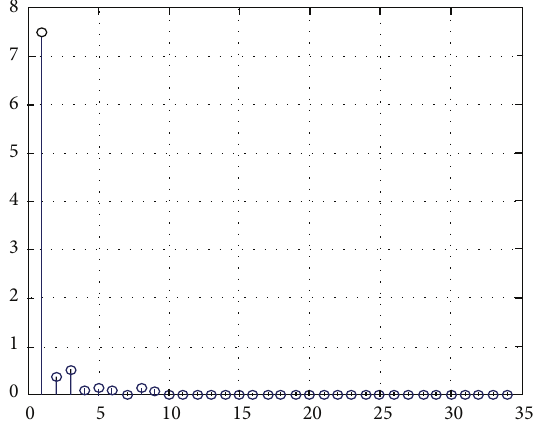
Figure 2: Amplitude spectrum of indicator